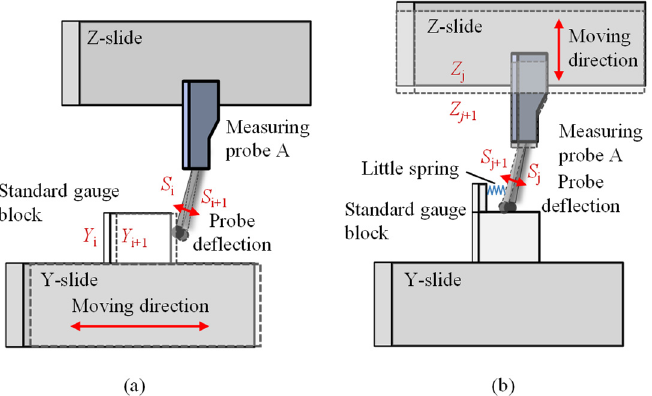
Figure 5. Schematic of calibration for the measurement of the lateral displacement gauge. ( a ) Hori- zontal calibration for the lateral probe; ( b ) vertical calibration for the lateral probe.